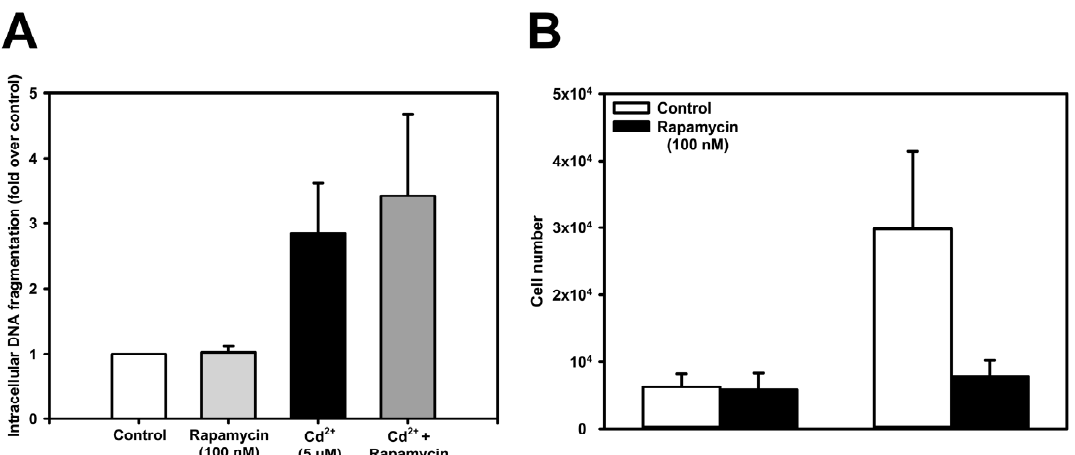
Figure 4. Effect of rapamycin on apoptosis and cell proliferation in Cd 2+ -exposed renal PT cells. NRK-52E cells were exposed to 100 nM rapamycin for 24 h in the absence or presence of 5 µM Cd 2+ and apoptosis was assayed by measuring intracellular DNA fragmentation ( A ). Cell number of subconfluent cells was determined in culture dishes ± rapamycin at time 0 and after 24 h by trypsinization and cell counting with a hemocytometer ( B ). During the experimental phase, cells were cultured in medium containing 1% FBS, similarly as described in [46]. Means ± SE of 3–8 different experiments are